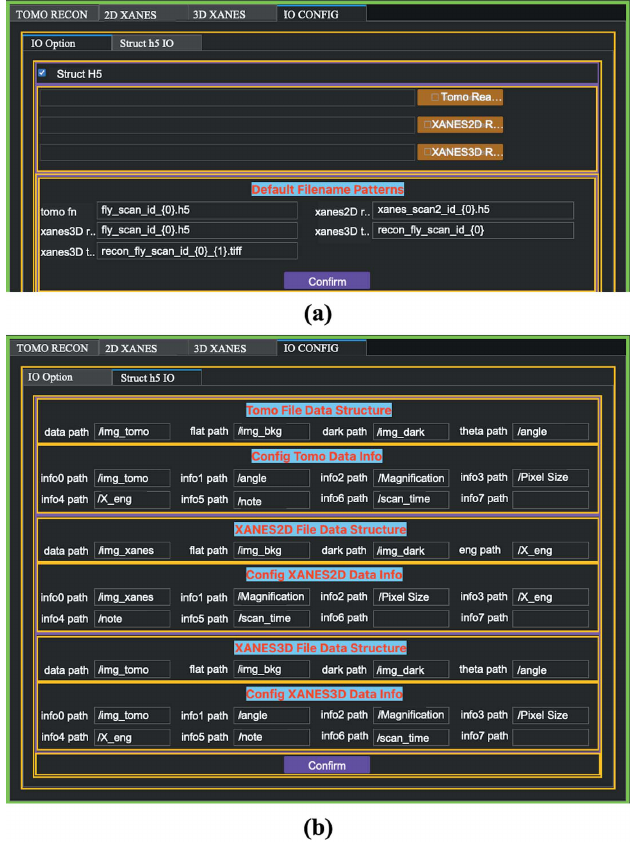
Figure 2 Customizable I/O module configuration. ( a ) Reader configuration; users can define customized readers for each type of data or use the default HDF5 file format. ( b ) HDF5 file structure